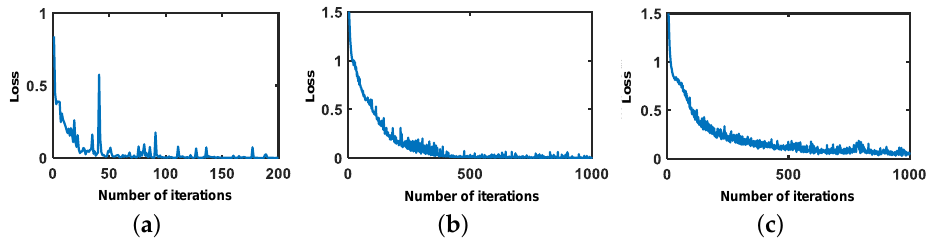
Figure 4. The convergence processes of the loss functions: ( a ) the driving intention prediction model. ( b ) Leftward lane change time prediction model. ( c ) Rightward lane change time prediction model. Table 1. The RMSEs of the predicted trajectories of each trajectory prediction model. Model